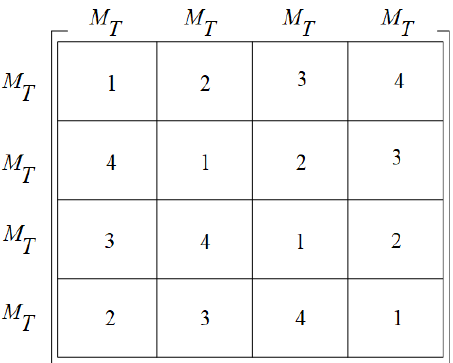
Figure 3. The block-based space-time threading structure ( M = L =